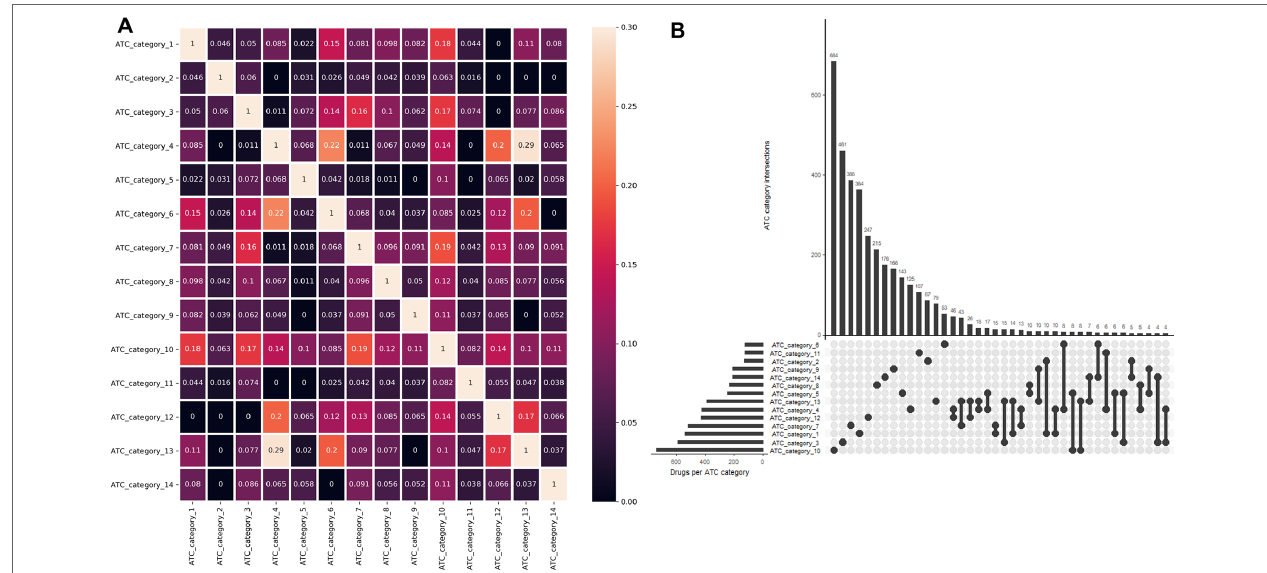
FIGURE 1 | Label correlation landscape. (A) The pair wise visualization of Cramér’s V statistics for all the labels in a heatmap manner. (B) The UpSet visualization of label intersections. The horizontal bar shows the number of drugs per ATC category, and the vertical bar shows the number of drugs per ATC category